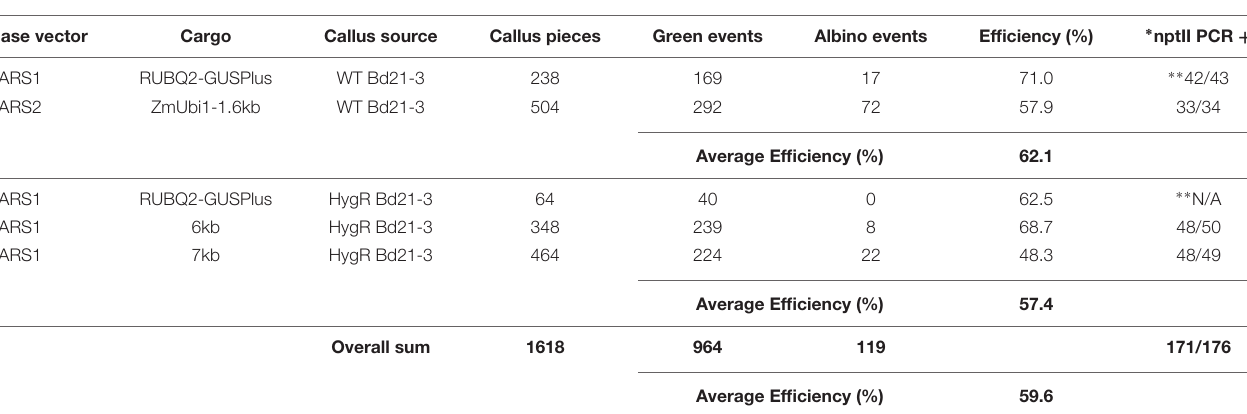
TABLE 2 | Transformation efficiency of B . distachyon selected on paromomycin. Base vector